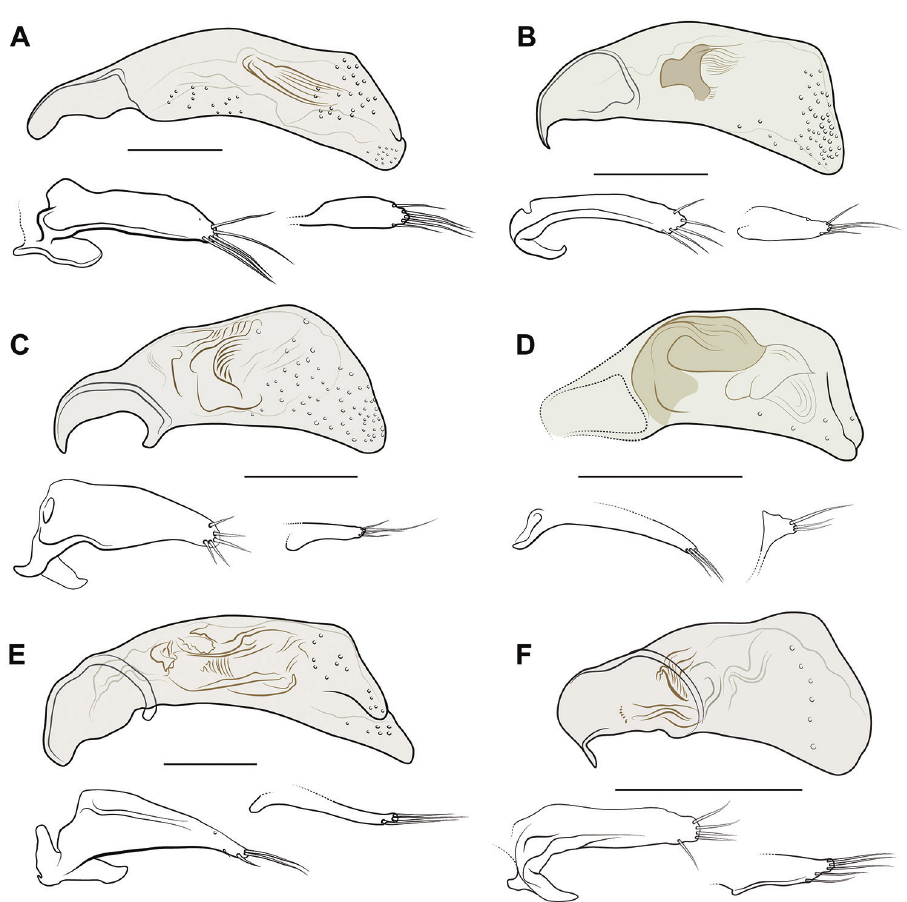
Figure 6. Illustrations of aedeagus, left lateral aspect, with parameres (left and right) shown below me- dian lobe. A Meotachys ( Hylotachys ) ballorum , DRM voucher DNA2854 B Nothoderis sp., DRM voucher DNA2870 C Nothoderis sp. , DRM voucher DNA2935 D Polyderis laeva , DRM voucher DNA2913 E Tachyxysta howdenorum , DRM voucher 4881 F Nothoderis rufotestacea , DRM voucher DNA0718. Scale bars = 0.1 mm.